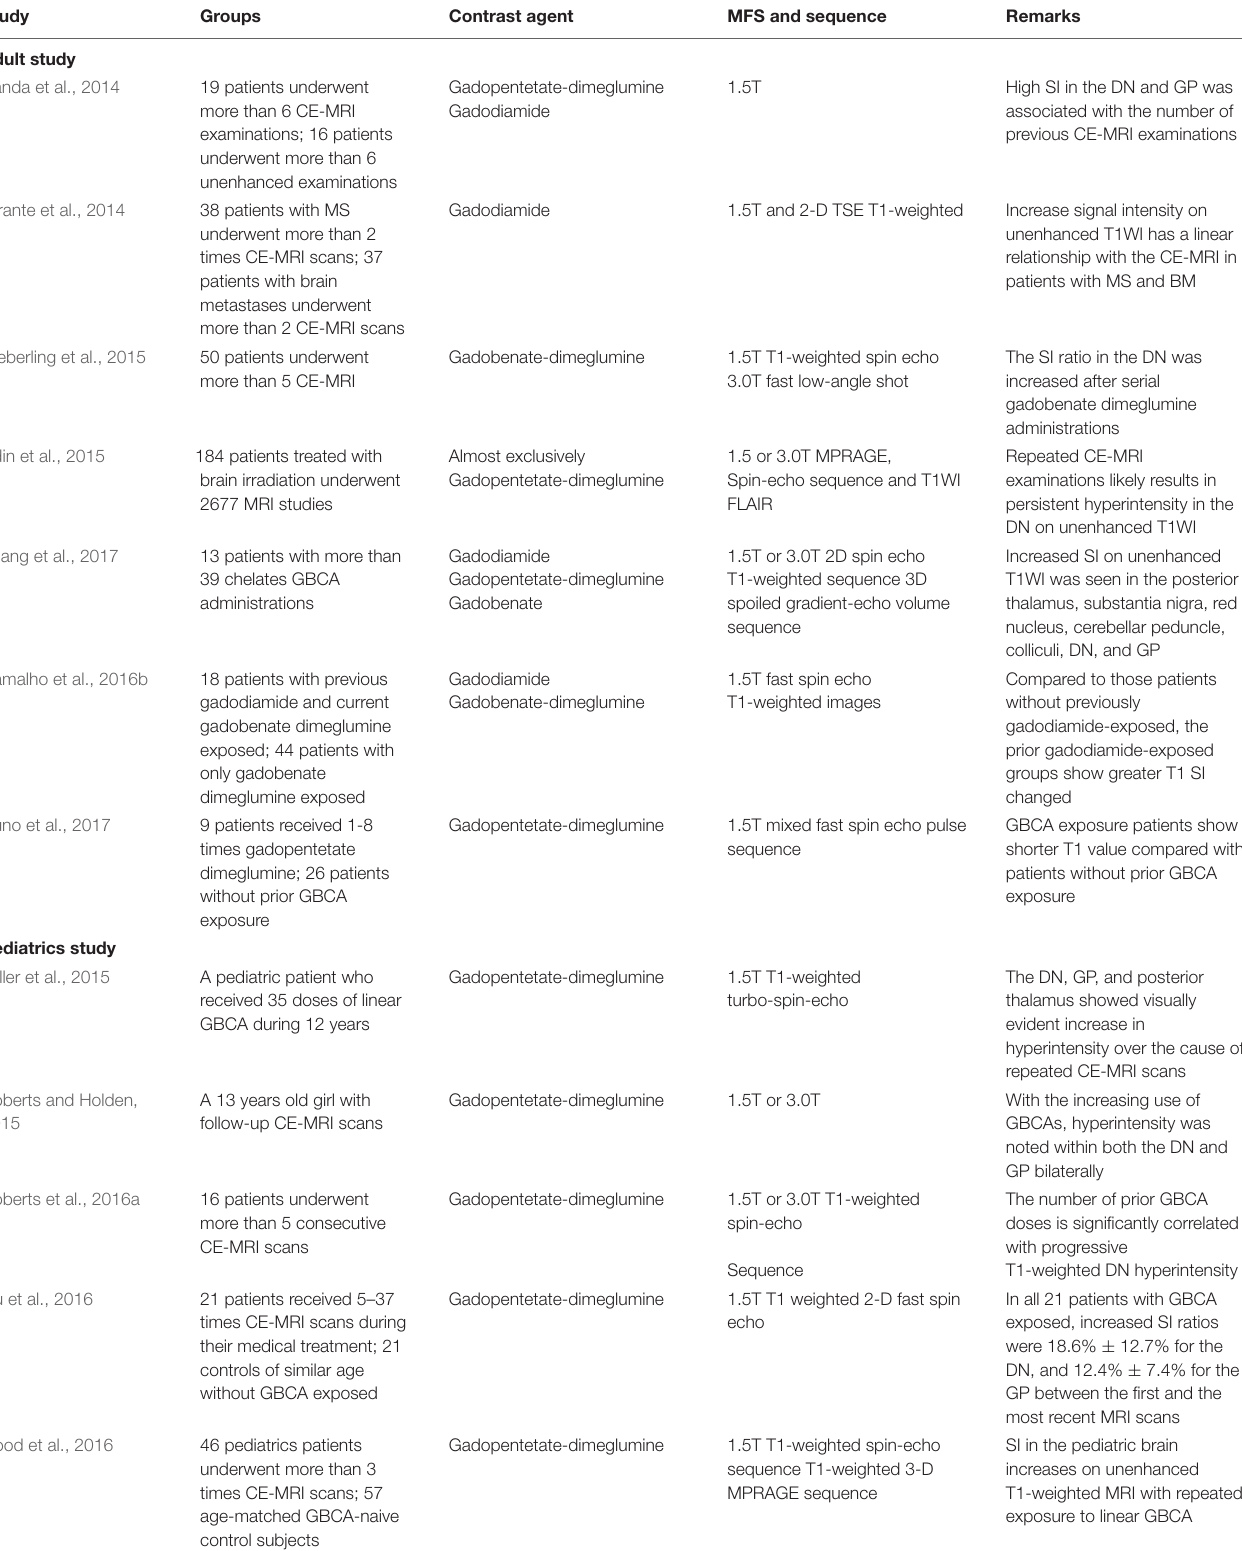
TABLE 2 | Association between CNS structures hyperintensity and GBCAs administration in